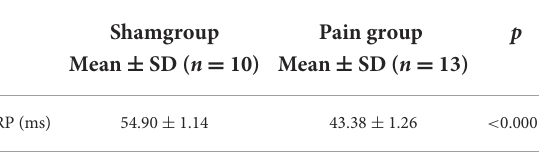
TABLE 2 The measurement of electrophysiological characteristics in the Langendorff perfusion model in sham and pain